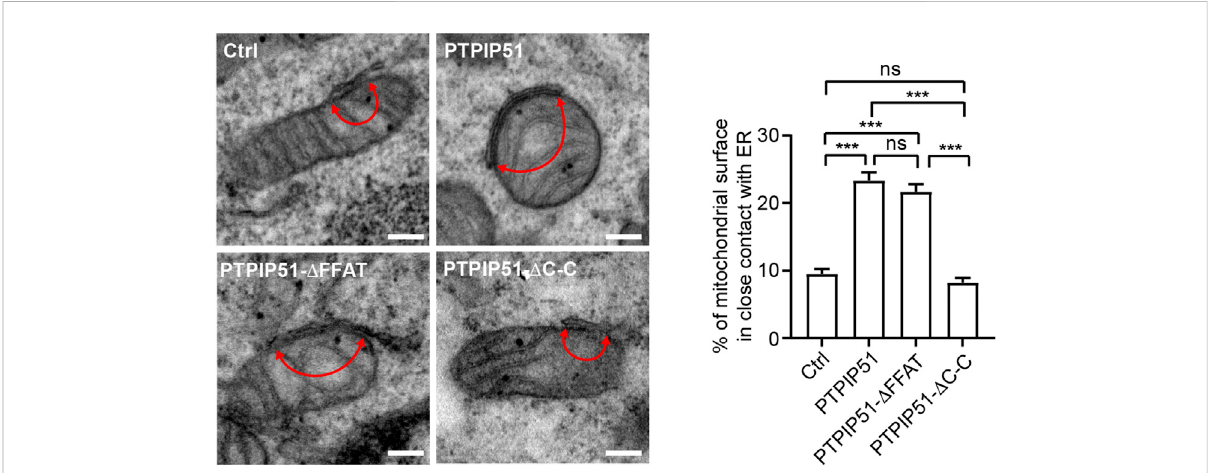
FIGURE 3 DeletionofthePTPIP51coiled-coilbutnotFFATmotifdisruptsER-mitochondriacontacts.HEK293cellsweretransfectedwithEGFPpluseither control vector, PTPIP51-HA, PTPIP51- Δ FFAT-HA or PTPIP51- Δ C-C-HA. Transfected cells were isolated using a cell sorter and the EGFP signal, replated and analysed by EM. Representative electron micrographs of ER – mitochondria contacts in control (Ctrl) PTPIP51-HA, PTPIP51- Δ FFAT-HA or PTPIP51- Δ C-C-HA transfected cells are shown. Arrowheads with loops show regions of contact. Scale bars = 200 nm. The bar chart shows the % of the mitochondrial surface in close ( < 30 nm distance) contact with ER. Data were analysed by Welch ANOVA and Games-Howell ’ s post hoc test. N = 20 – 32 cells and 98 – 124 mitochondria. Error bars are s. e.m. ns, not signi fi cant, *** p ≤